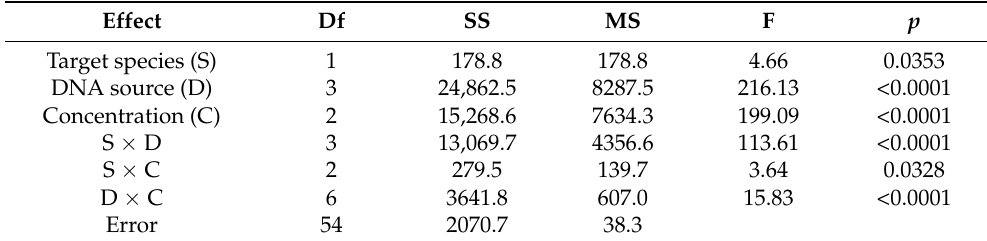
Table 1. Results of the ANOVA carried out on root elongation data from the cross-factorial experiment. Tested effects include main and second order effects of target species (S, two levels, S. italica and S. pumila ), DNA source (D, four levels: S. italica , S. pumila , B. napus , S. salar ), and concentration (C, three levels, 2, 10, and 50 ng/ µ L). Df = Degrees of freedom; SS = Sum of Squares; MS = Mean Sum of Squares; F = F statistic ratio; p = p